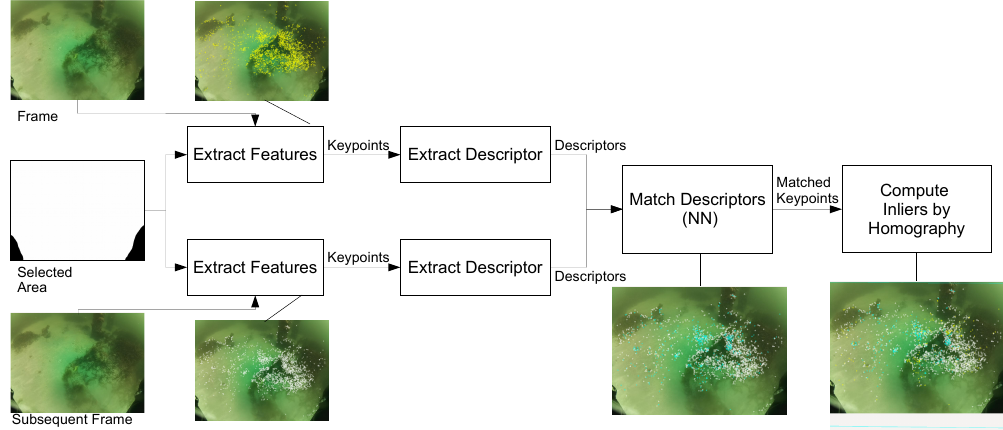
Figure 3. Block diagram of data extraction for evaluation. First, features are extracted and described from two consecutive frames (features in yellow and white for frame and subsequent frame respectively). Then features are matched between both frames (cyan points on the subsequent frame show matches, white points, rest of features). Finally inliers (cyan points) and outliers (yellow points) are